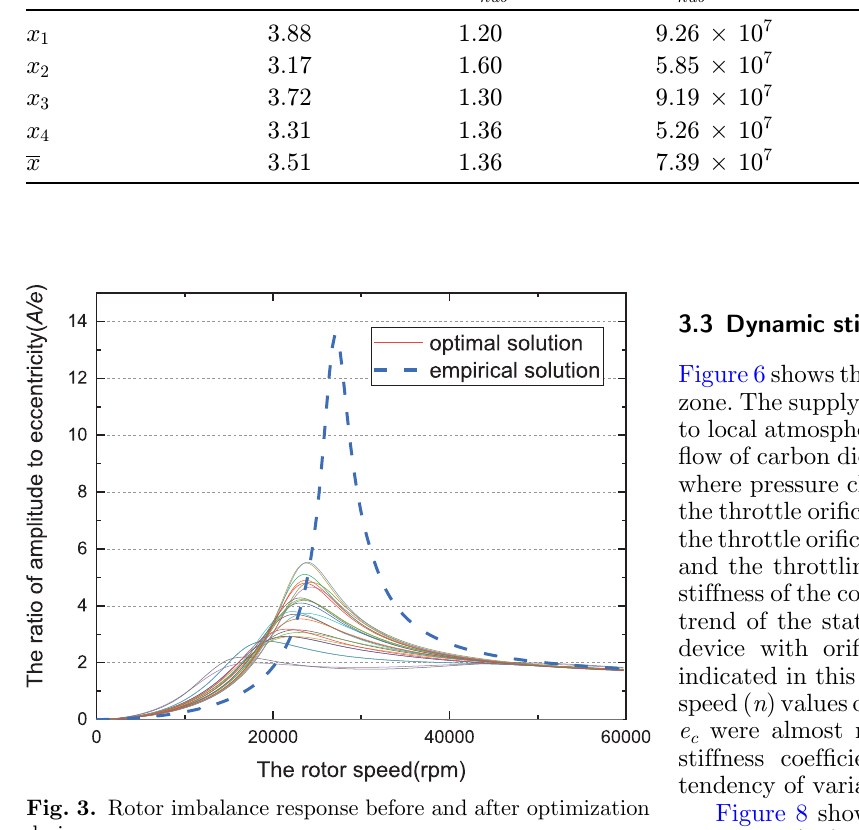
Table 3. Optimized parameters. Particles